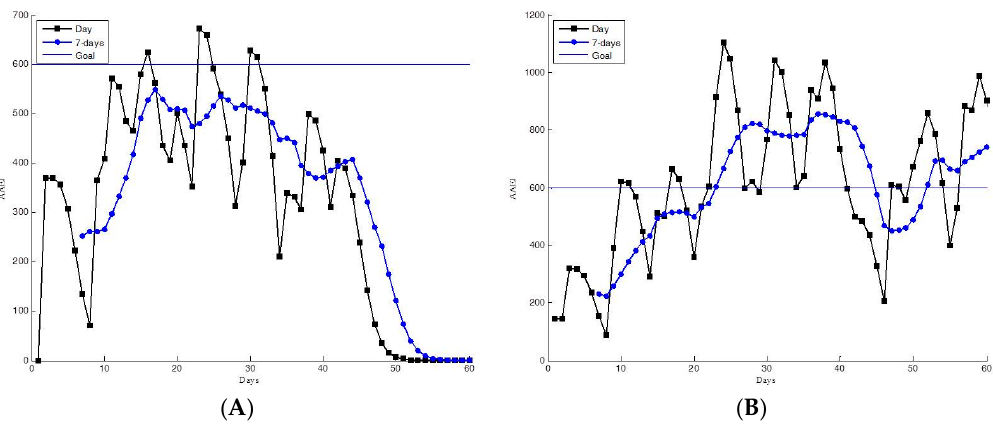
Figure 9. Participants with moderate AAEI values, as determined the 60-day trial. ( A , B ) Participants typically had AAEI values between 400 and 600.